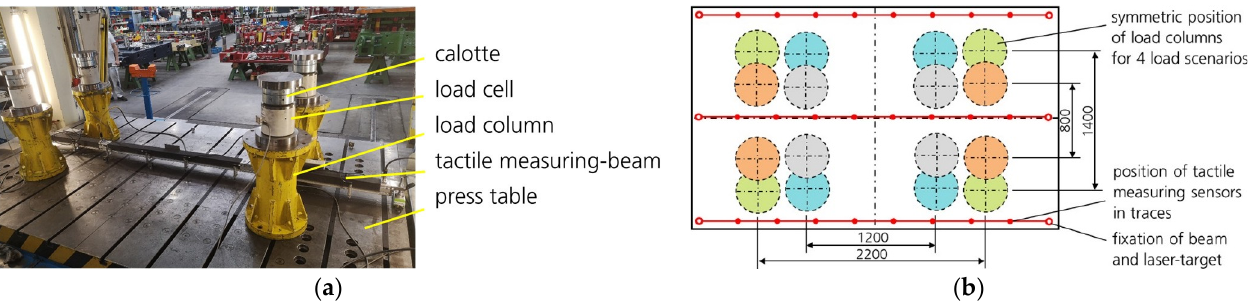
Figure 1. ( a ) Apparatus for load application and measurement of load via load cells as well as elastic deflection of the press table via tactile measurement beam in the workspace of a hydraulic press. ( b ) Positions of the four load columns on the press table (and ram, identically) for four different load scenarios (different colors) as well as the position of three tactile measurement beams.